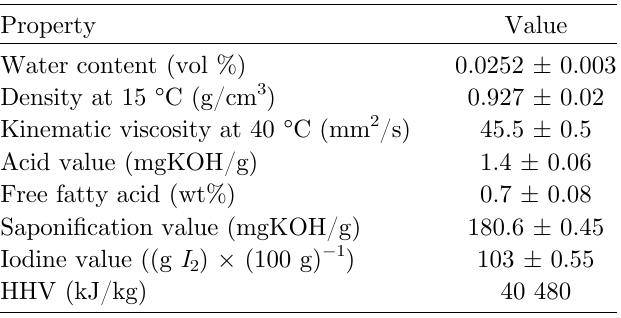
Table 2. Physicochemical properties of